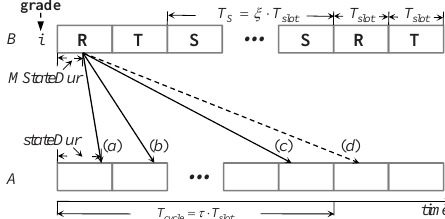
Figure 3. Cases ( a ), ( b ), and ( c ): node A receives a DIVISION message from node B in the current cycle; case ( d ): it receives a message in the next